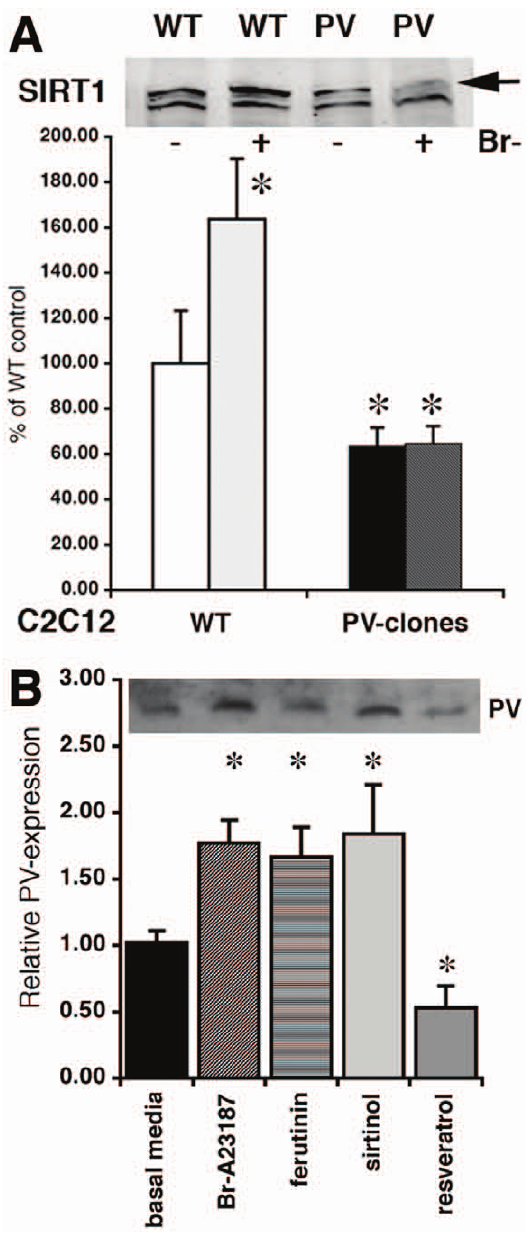
Figure 6. Expression levels of SIRT1 and SIRT1-dependent regulation of PV expression in C2C12 PV-clones. Exposure of WT C2C12 to Br-A23187 for 48 h increased SIRT1 expression (arrow) in WT C2C12 cells exposed to Br-A23187 determined by Western blot analysis; quantitative results are shown in the histographs (*: p , 0.05) SIRT1 levels in PV-clones were lower, even under control conditions and ionophore treatment didn’t cause a change in SIRT1 expression in PV- clones (*; p , 0.05 compared to WT, basal conditions). Only the upper band (arrow) is the specific band corresponding to the expected size of SIRT1 and was used for the quantitative analysis. B) At 48 h post- treatment PV expression levels in C2C12 PV-clones were increased by the ionophores Br-A2319987 and ferutinin or by blocking of SIRT1 activity by sirtinol. On the contrary, addition of resveratrol activating the SIRT1/PGC-1 a signaling axis led to a decrease in PV expression (*, p , 0.05 vs. untreated C2C12 PV-clones).